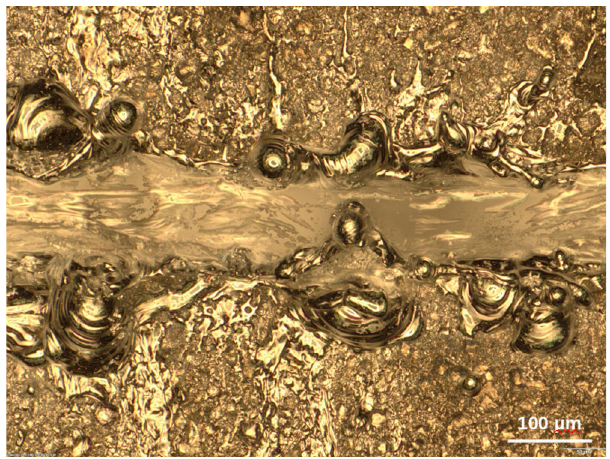
FIG. 31. Flattened image of multiple-strike zone at y ¼ − 2 . 6 mm; SN 14-18 (Table VI). off